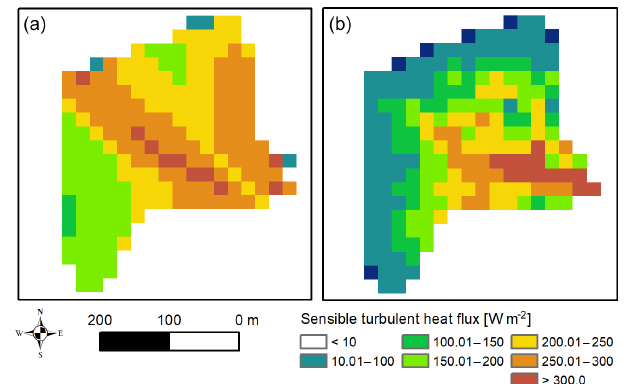
Figure 14. The sensible turbulent heat flux at the ice field surface modelled with the atmospheric model ARPS, initialized by a sta- ble atmosphere involving a well-developed katabatic flow (set-up 1, a ) and by a neutral atmosphere involving a shallow katabatic flow onset at the ice field surface (set-up 2, b